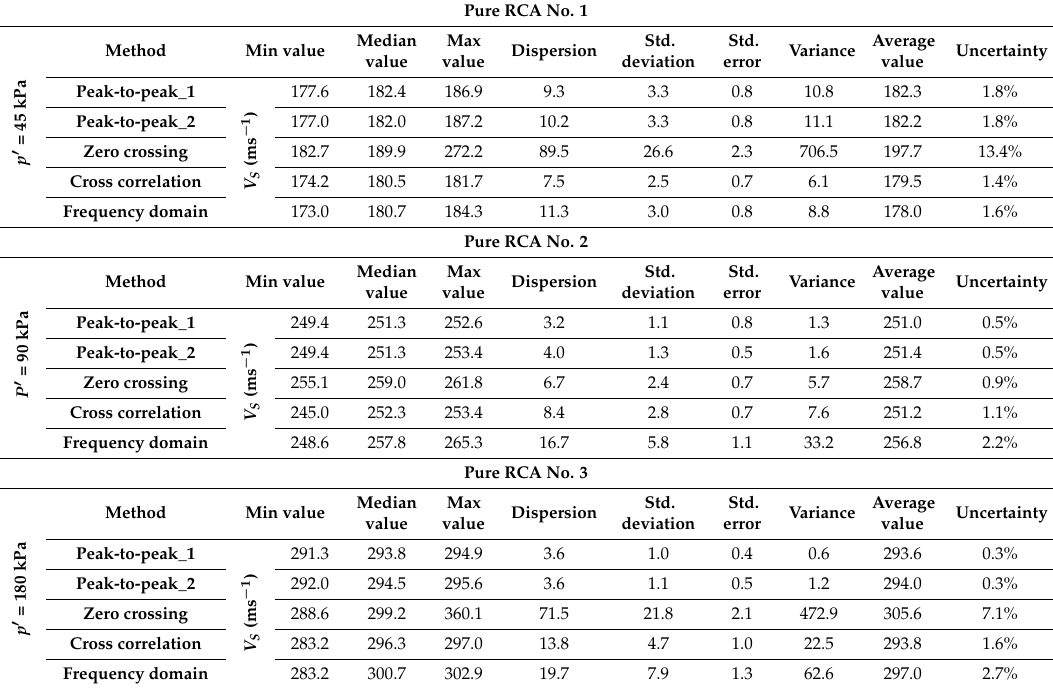
Table 5. Result of statistical analysis of pure RCA specimens from different methods of travel time identification in bender element testing. Pure RCA No. 1